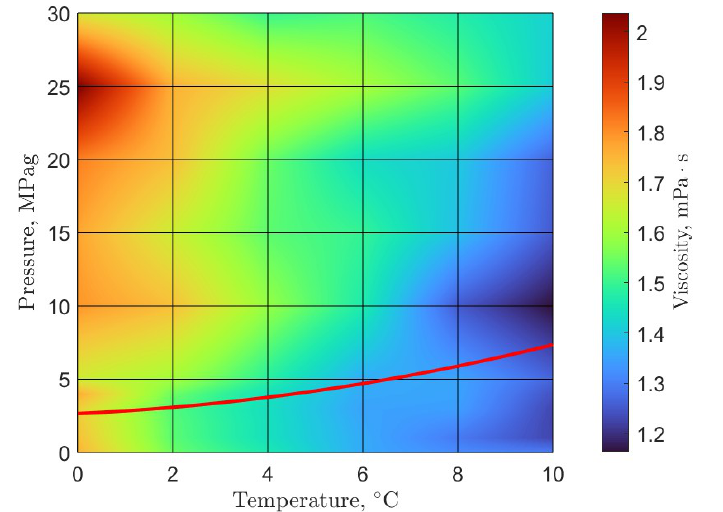
Figure 2. Rheological phase diagram of methane gas hydrates: the viscosity of pre-nucleation and early hydrate formation systems overlayed with the three-phase hydrate-liquid-gas equilib- rium line (red line); equilibrium data from Carroll in Natural Gas Hydrates [3]; figure adapted from Guerra et al. [21].